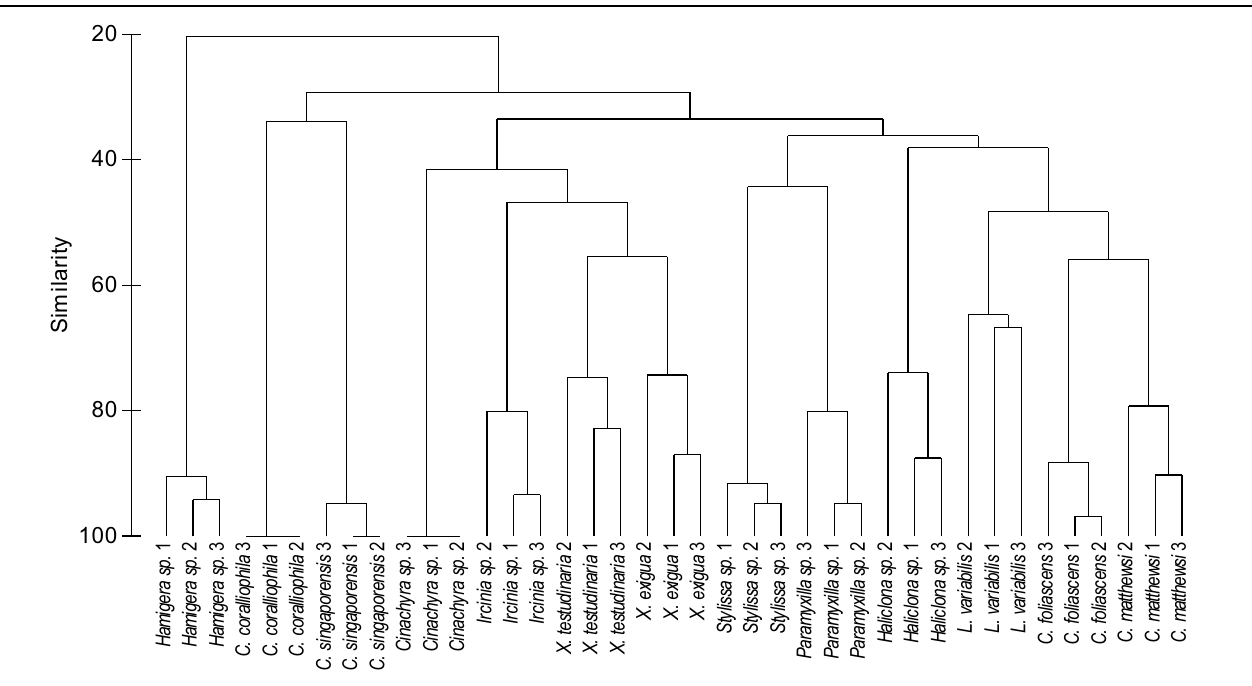
FIGURE 2 | Cluster analysis (based on DGGE banding pattern data) for different sponge species using Group Average and Bray Curtis similarity.